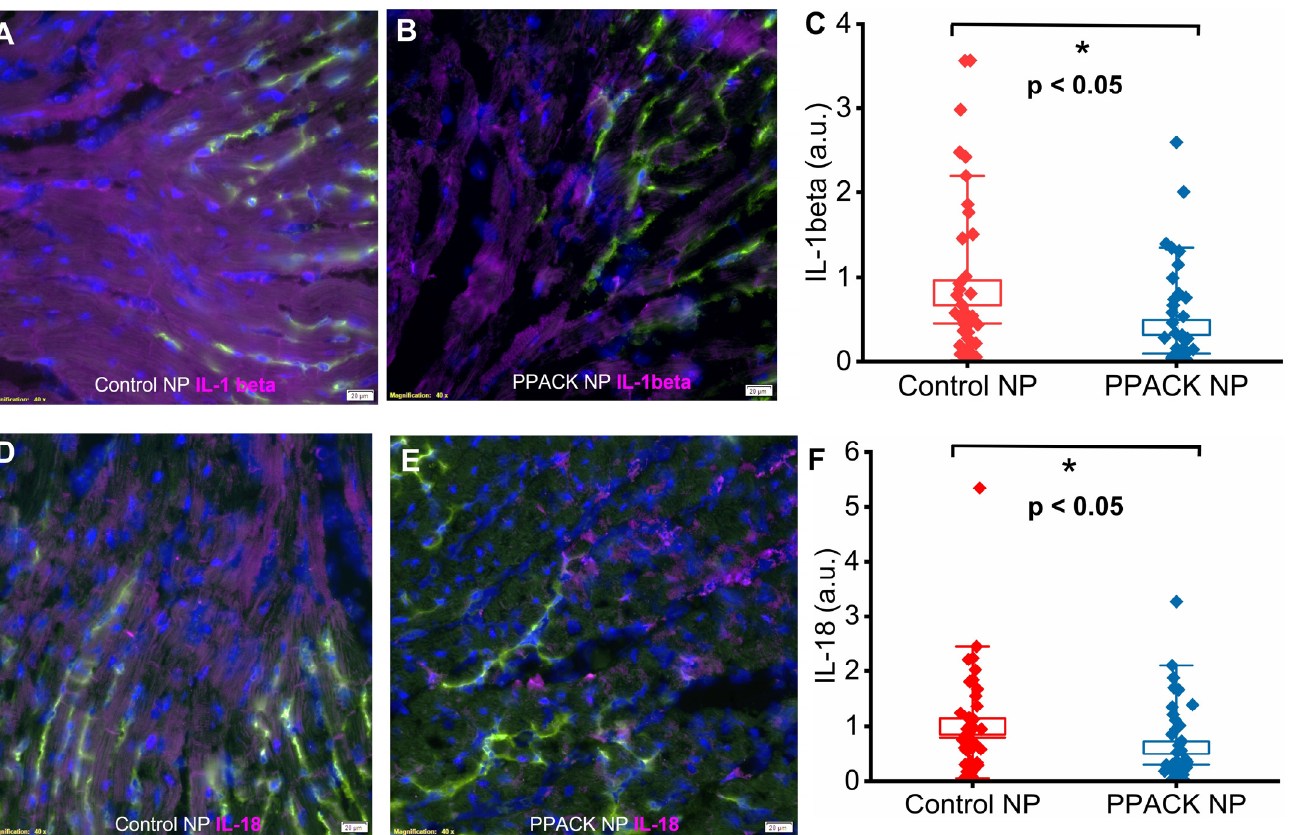
Figure 7. PPACK PFC NP treatment inhibits pro-inflammatory cytokine expression. ( A ) Immunofluorescent image of IL-1beta (purple) staining in control NP-treated hearts. ( B ) Immunofluorescent image of IL-1beta (purple) staining in PPACK NP treated hearts. Green fluorescence signal indicates blood vessels in the normal region of the heat. DAPI was used for nuclei staining (blue). The size of the scale bar was 20 µm, and the magnification was 20×. ( C ) Quantification of IL-1beta signal in border zones of control NP vs. PPACK NP hearts ( n = 3 mice per group; n = 45 PPACK NP and n = 45 control NP regions of interest. Mean ± SEM; nonparametric analysis on n = 3). ( D ) Immunofluorescent image of IL-18 (purple) staining in control NP-treated hearts. ( E ) Immunofluorescent image of IL-18 (purple) staining in PPACK NP treated hearts. Green fluorescence signal indicates blood vessels in the normal region of the heat. DAPI was used for nuclei staining (blue). The size of the scale bar was 20 µm, and the magnification was 20×. ( F ) Quantification of IL-18 in border zones of control NP vs. PPACK NP hearts ( n = 3 mice per group; n = 40 PPACK NP and n = 42 control NP regions of interest. Mean ± SEM; nonparametric analysis on n = 3; *: p < 0.05).